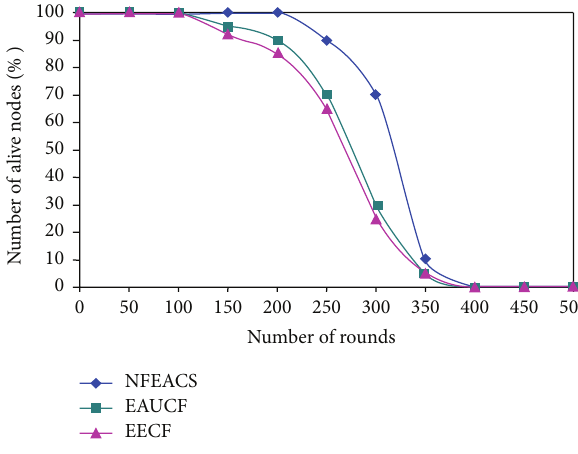
Figure 9: Number of alive nodes in each round. sensor nodes are mobile in network. NFEACS achieved 37% energy efficiency compared to related